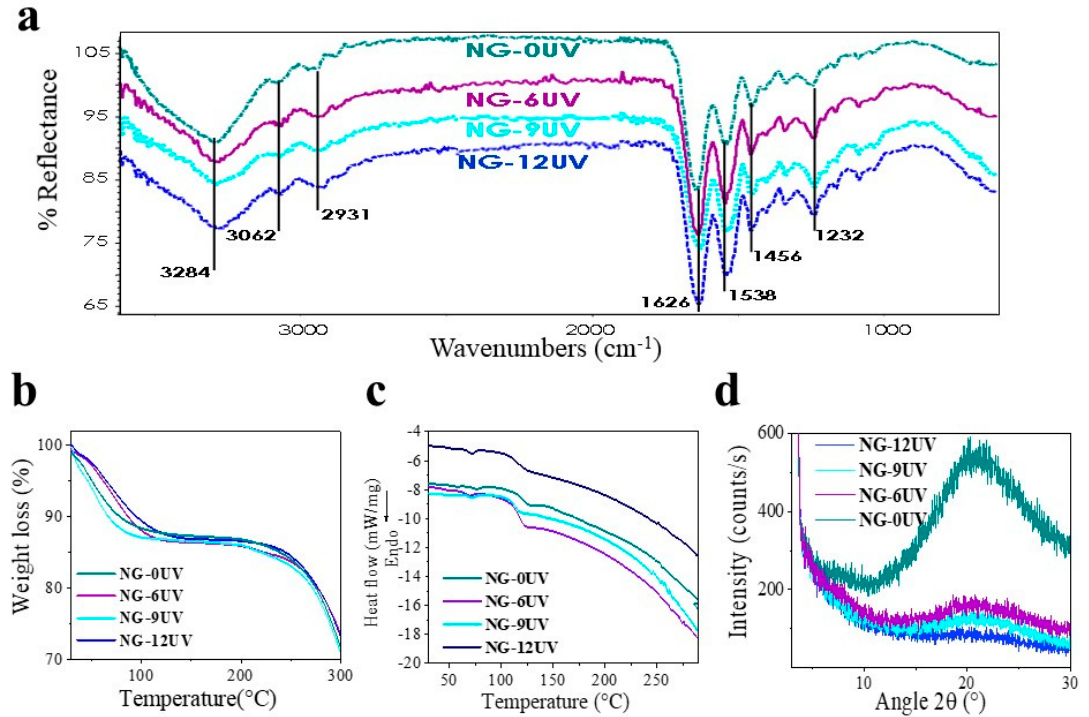
Figure 2. Characterization of samples by ( a ) ATR-FTIR, ( b ) TGA, ( c ) DSC, ( d ) XRD.